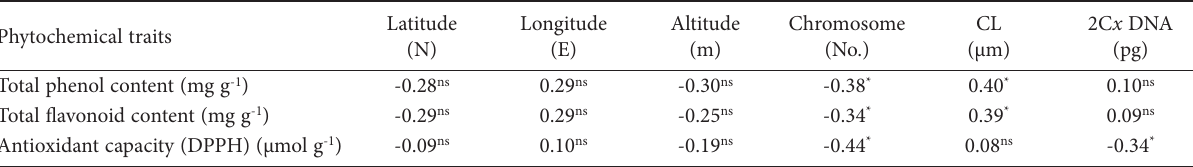
Table 5. Correlation coefficients between phytochemical traits of 12 berry species with chromosome number, chromosome length, the mon- oploid genome size (2C x DNA), and environmental conditions Phytochemical